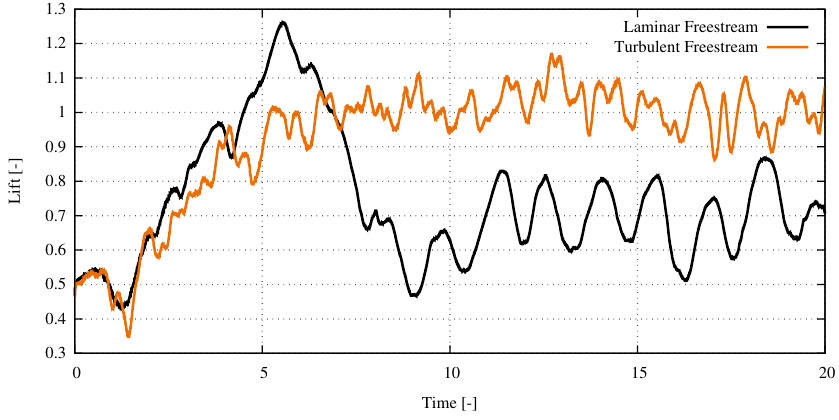
Figure 14. Temporal evolution of the lift